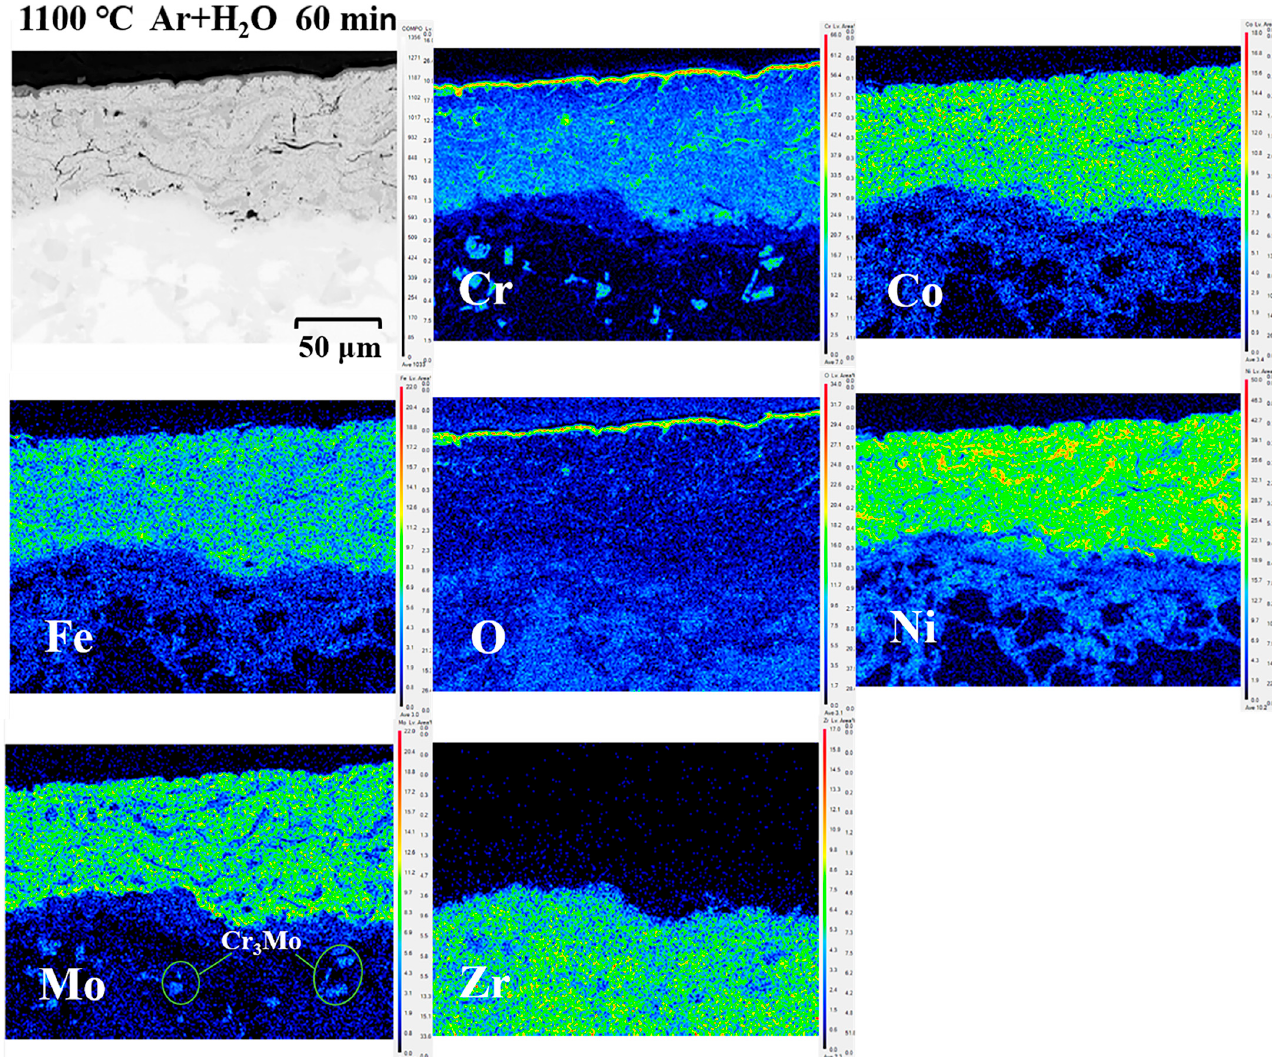
Figure 8. EPMA elemental mapping of the FeCoNiCrMo coatings after 60 min of oxidation at 1100 °C in a steam environment.